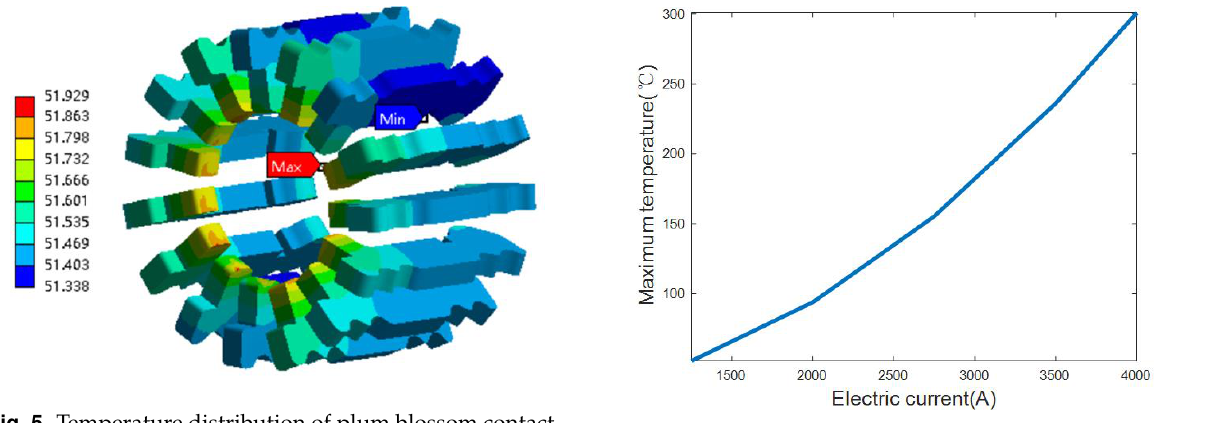
Fig. 7. Variation curve of the maximum temperature of plum blossom contact with current value under steady-state conditions